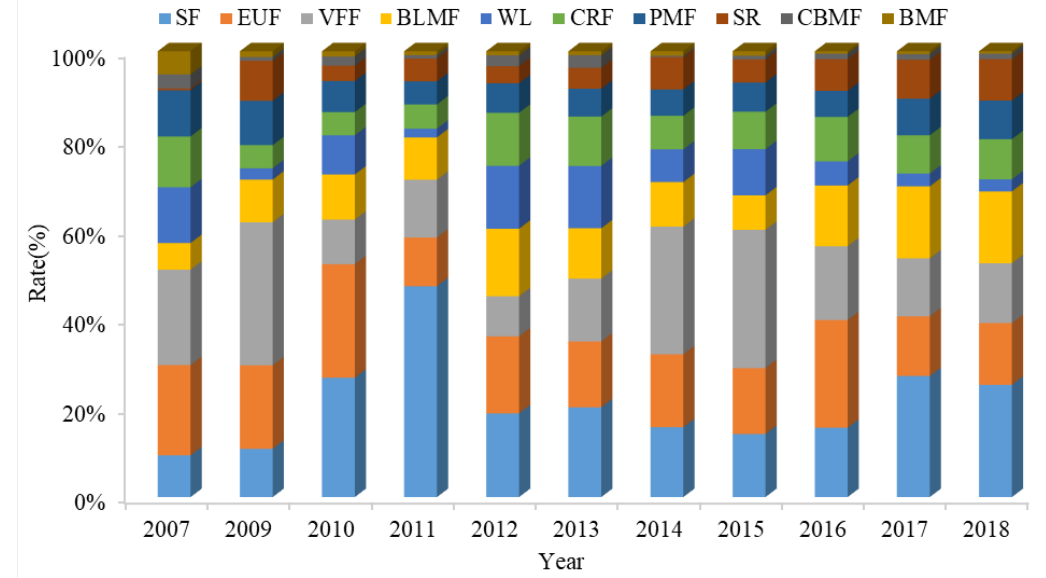
Table 2. Percentage (%) of vegetation types from 2007 to 2018.